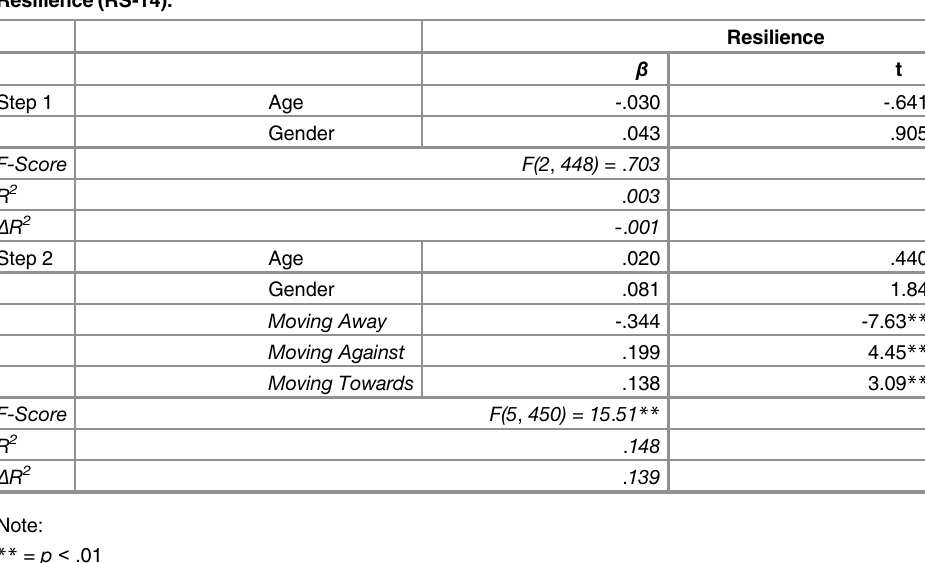
Table 9 shows the results of the final two -step hierarchical regression. After age and gender were accounted for, the 11 HDS traits accounted for an additional 20.3% of the variance, with Diligent, Bold and Imaginative positively predicting resilience, whilst Excitable (and Cautious negatively predicting.